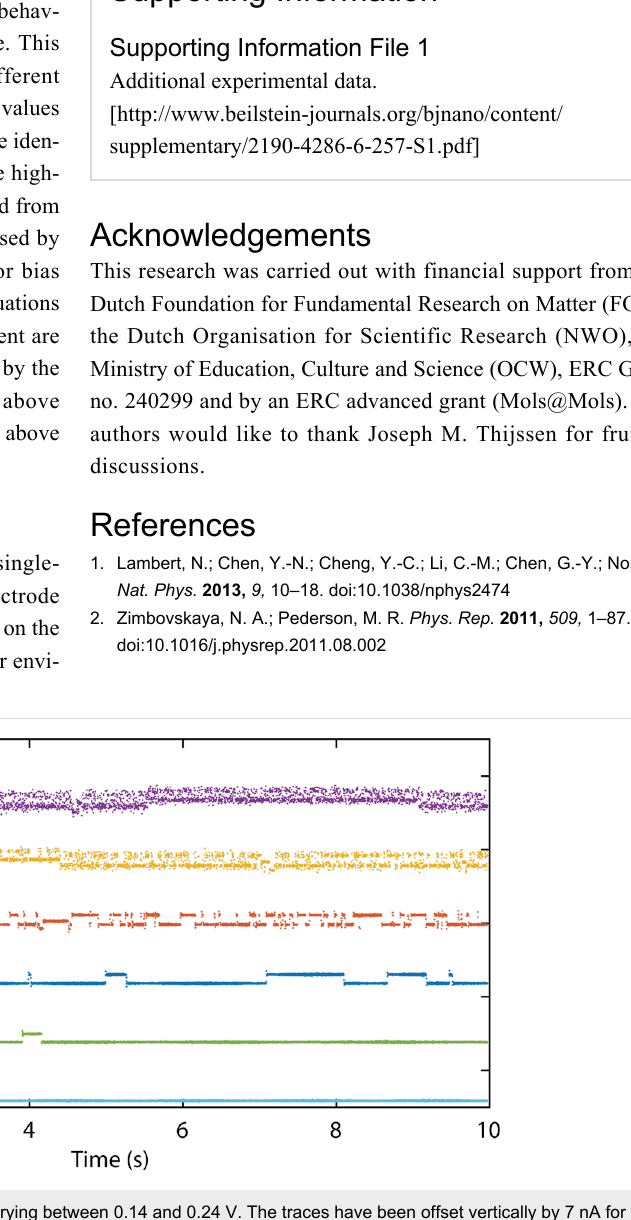
the interface between the molecule and the metallic electrodes or in the electronic